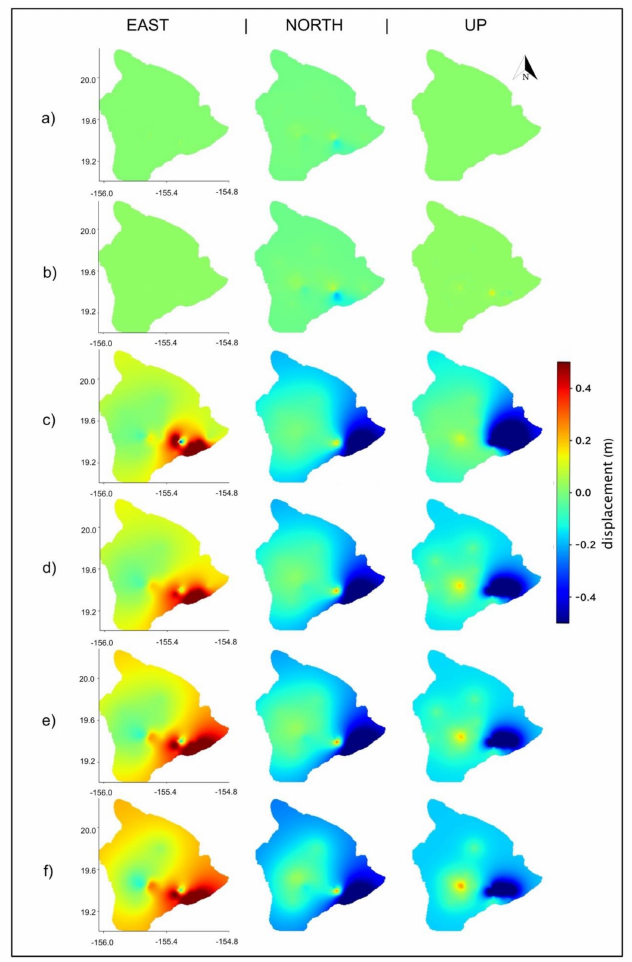
Figure 4. Interpolated GNSS displacement maps generated using 48 Hawaiian GNSS stations and the ordinary kriging algorithm. Each submap corresponds to the total deformation